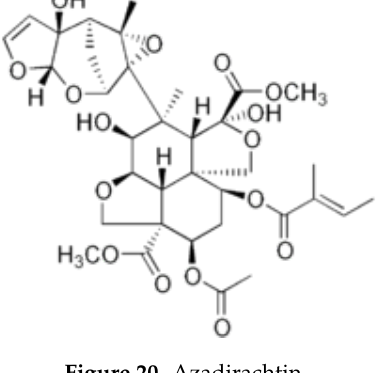
Figure 20. Azadirachtin. Figure 20.